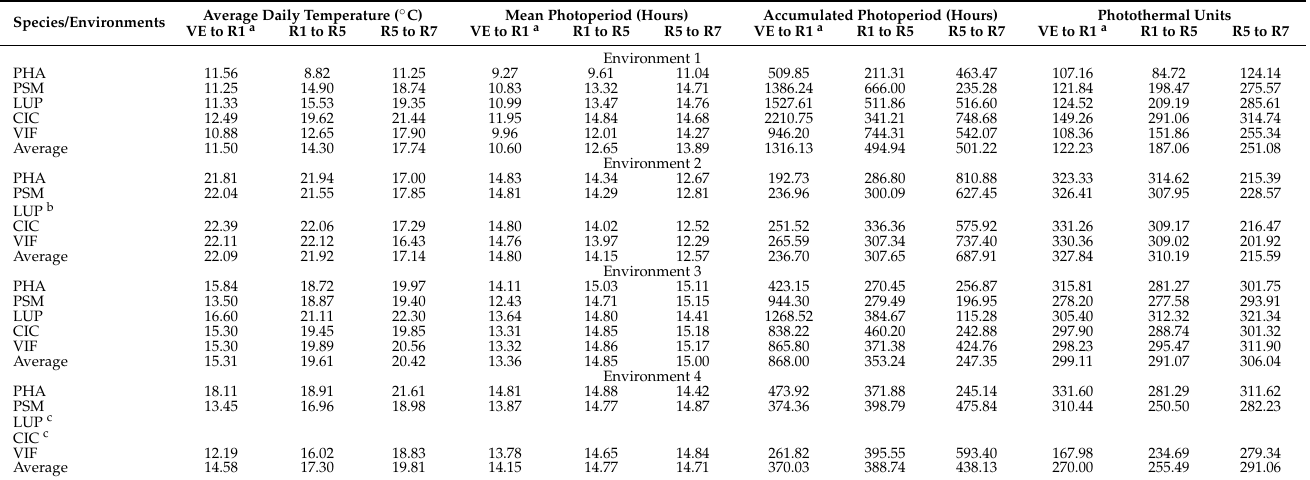
Table 2. Average daily temperature and photoperiod in each environment during the vegetative (VE–R1), early reproductive (R1–R5), and late reproductive (R5–R7) developmental phases. Develop- mental phases were measured according to